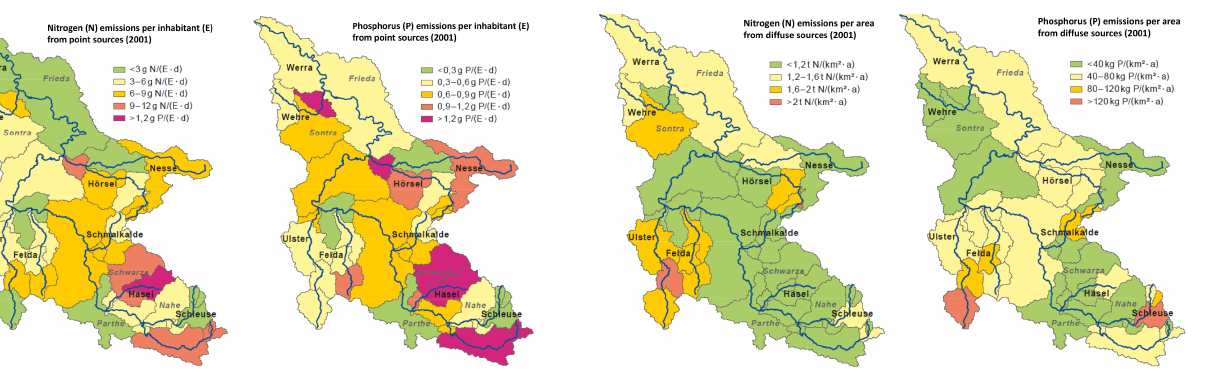
Figure 3. Nitrogen emissions (left) and Phosphorus emissions (right) from diffuse sources, indicating priority areas for measures (changed from Dietrich and Schumann, 2006).